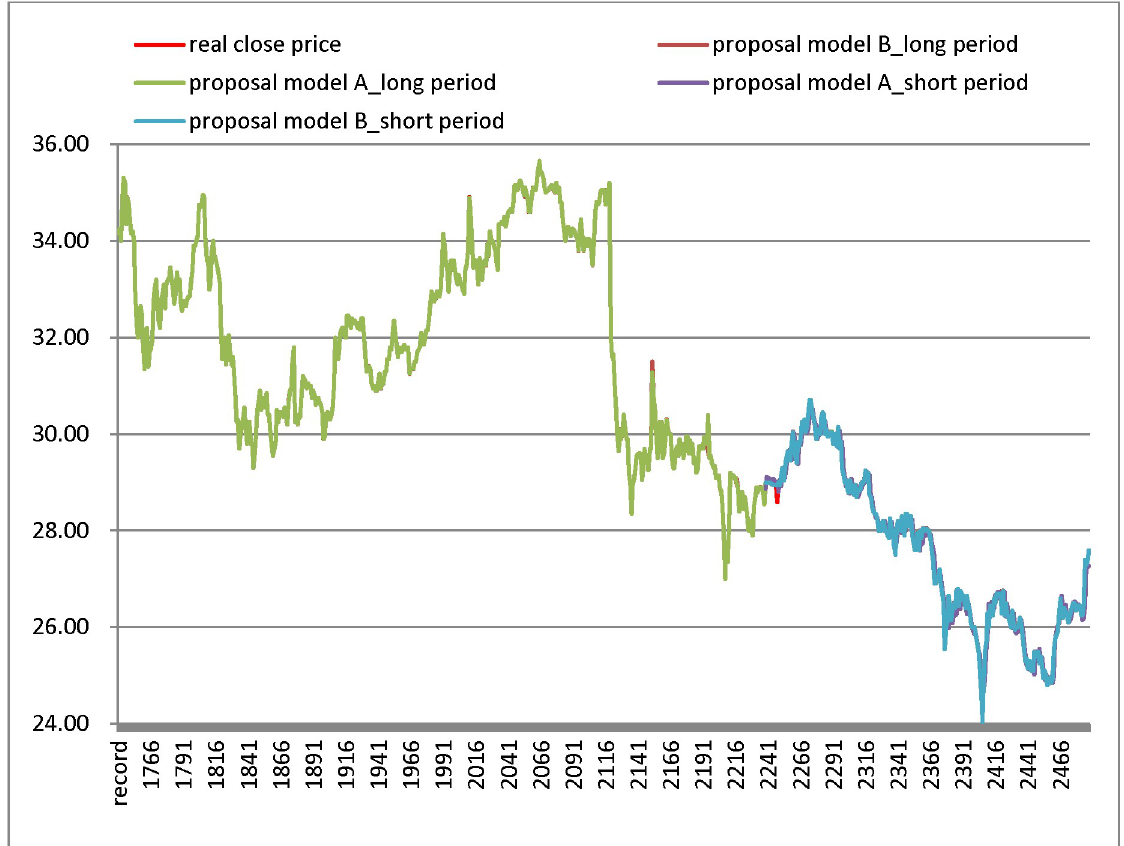
Fig 3. Results of forecasting short and long test period for China Steel